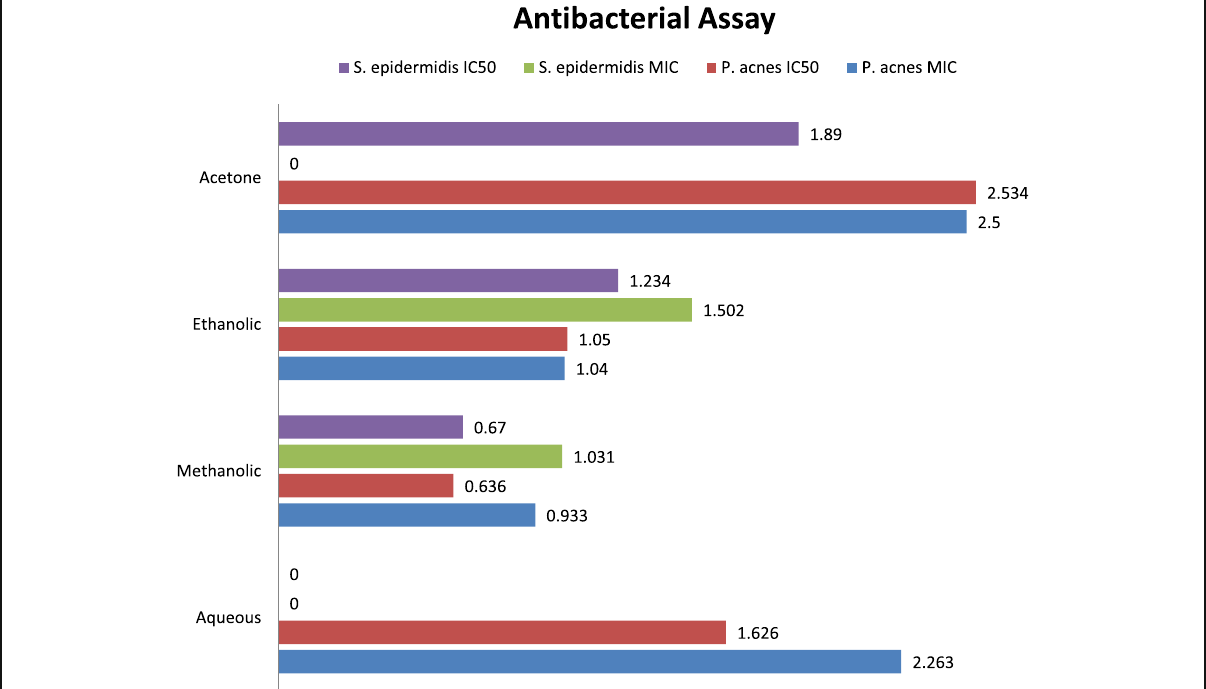
Fig. 3 Graphical presentation of activity of Olea europaea leaf extracts (acetone, ethanol, methanol and aqueous) in IC50 and MIC (mg/ml) against S. epidermidis and P.